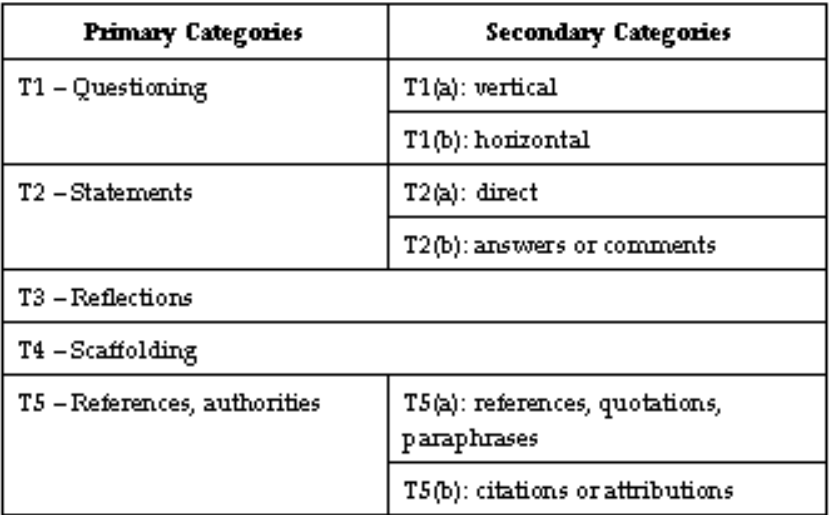
Table 1: Primary and secondary categories in the Transcript Analysis Tool